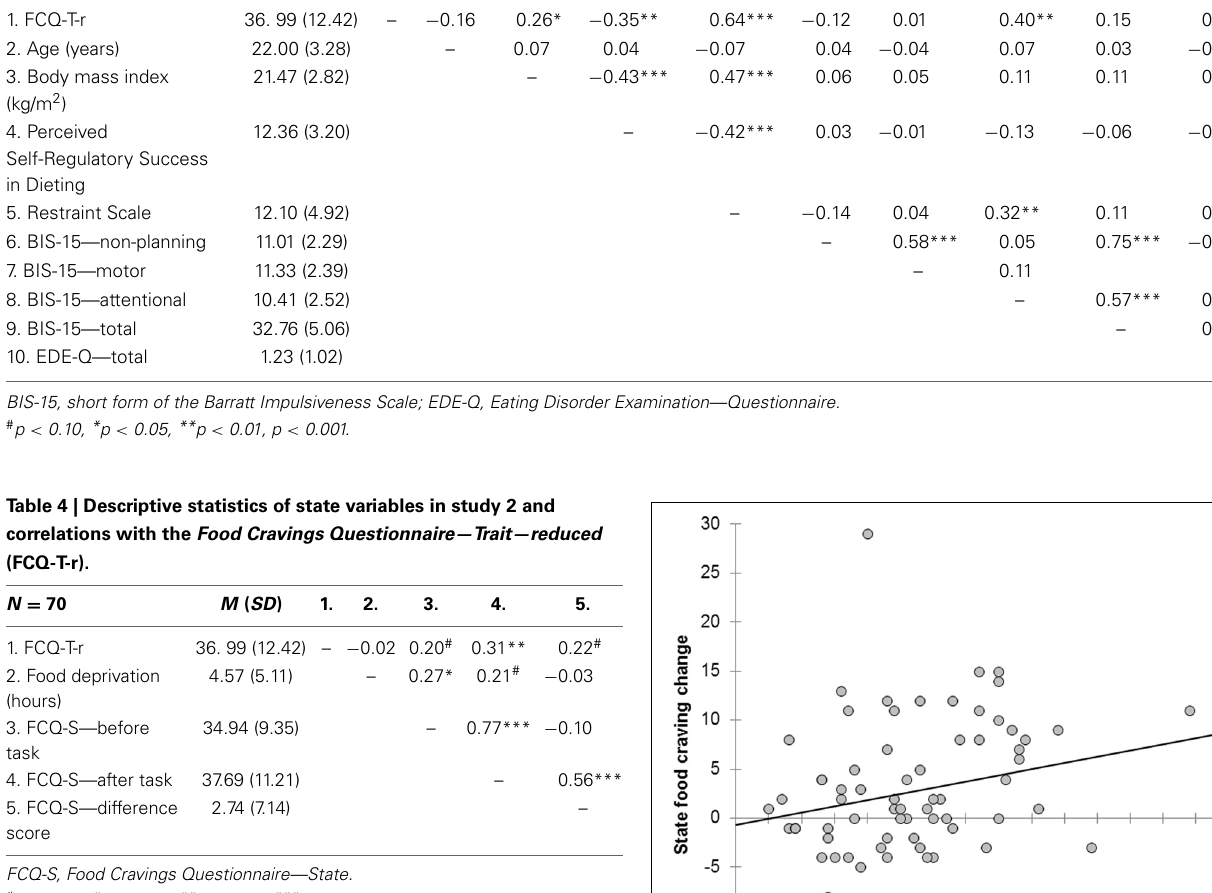
Table 3 | Descriptive statistics of trait variables in study 2 and correlations with the Food Cravings Questionnaire—Trait—reduced (FCQ-T-r). N = 70